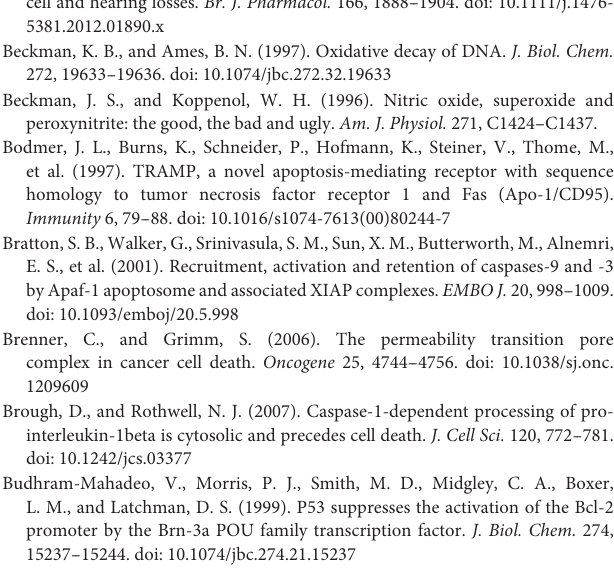
4 ). Glucocorticoids can reduce extracellular inflammatory cell trafficking, reduce the level of TNF α expression in spiral ligament fibrocytes, and bind to its glucocorticoid receptors in auditory HCs to activate pro-survival NFkB signaling and inhibit JNK signaling. Additionally, they can reduce oxidative stress, and regulate pro-death and pro-survival gene transcription (Maeda et al., 2005; Tahera et al., 2006; Dinh et al., 2008a,b, 2011; Bas et al., 2012b). Regulation of